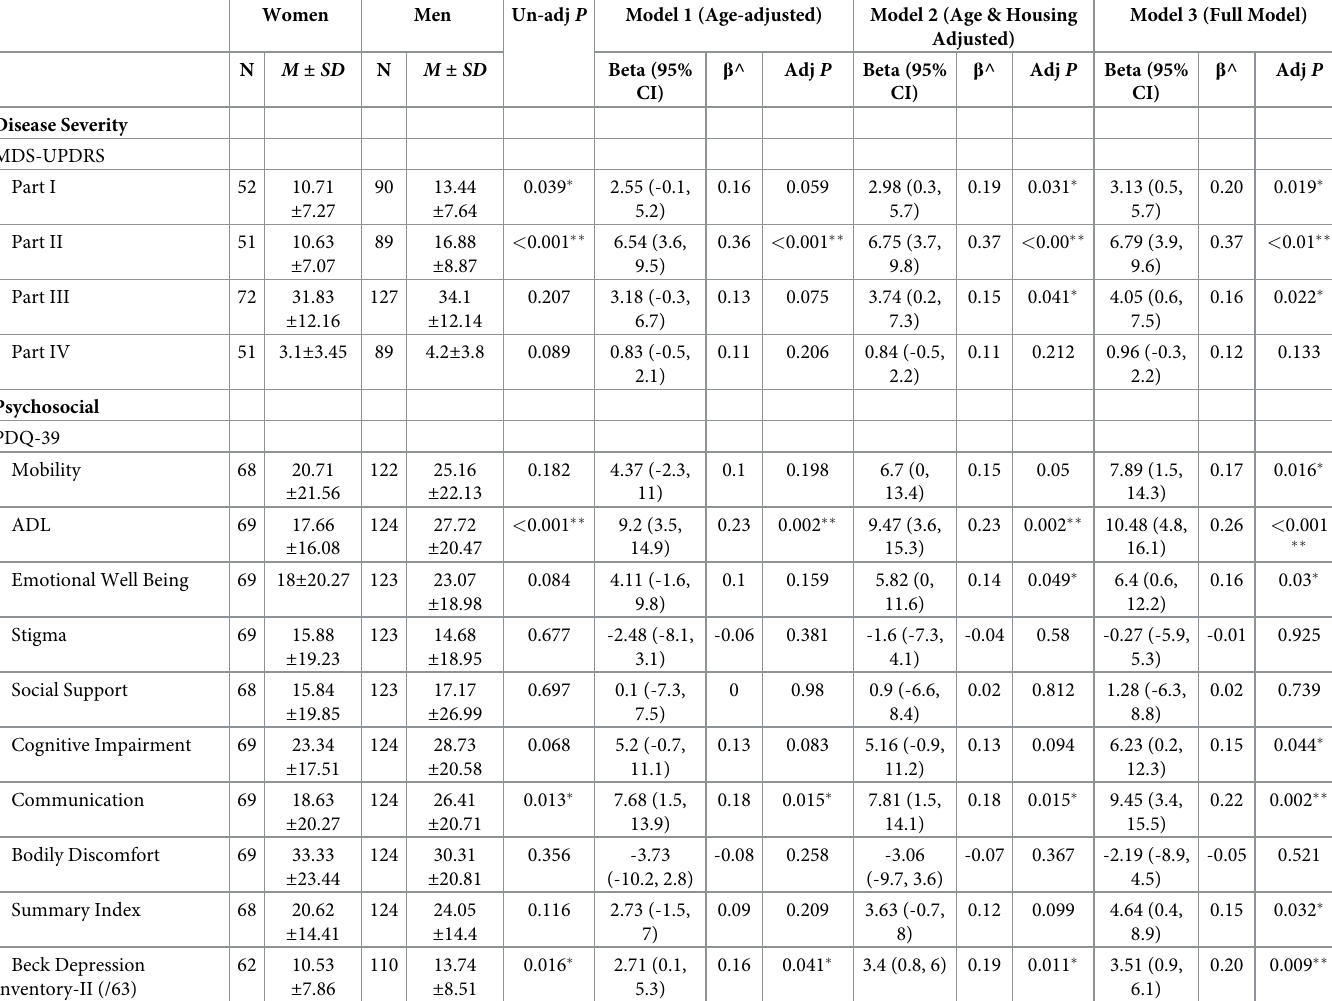
Table 2. Differences between women and men on disease severity, symptoms and psychosocial function.